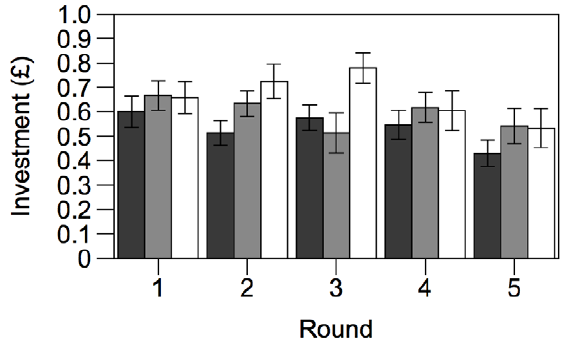
Figure 2. Investment in the public goods game. Raw data (means 6 standard error) of investment by participants in the three treatment conditions in rounds 1-5 of the game.